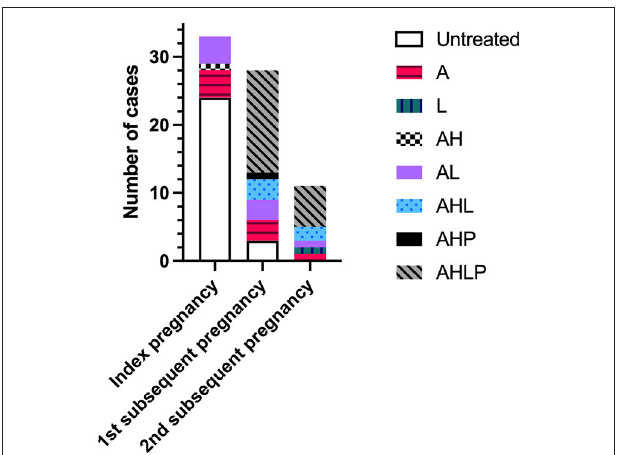
FIGURE 2 | Treatment regimen across index pregnancies with chronic histiocytic intervillositis (CHI) and first and second subsequent pregnancies. Index pregnancy was defined as a participant’s first pregnancy diagnosed with CHI by placental histopathological examination following poor outcome. Subsequent pregnancies refer to those following diagnosis. A, aspirin; H, hydroxychloroquine; L, low-molecular-weight heparin; P, prednisolone.